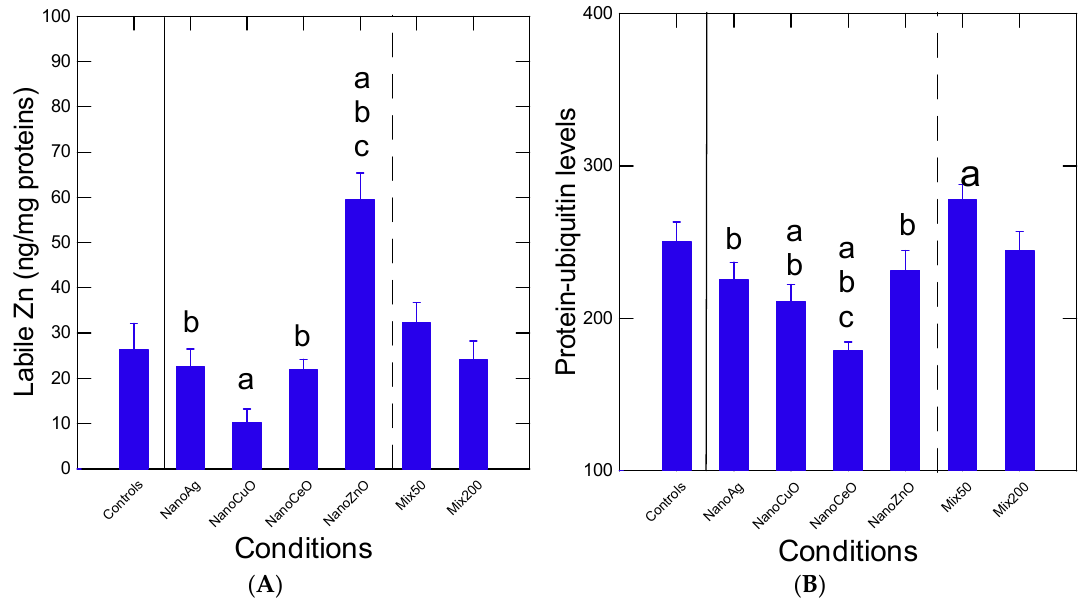
Figure 4. Labile Zn and protein ubiquitin levels in mussels exposed to nanoparticles and their mixture. Labile Zn ( A ) and Protein-ubiquitin ( B ) levels were determined in mussels. The data represent the mean with the standard deviation. The letters a denotes a significant difference to controls, the letter b a significant effect from the Mix50 and c a significant difference from Mix200.